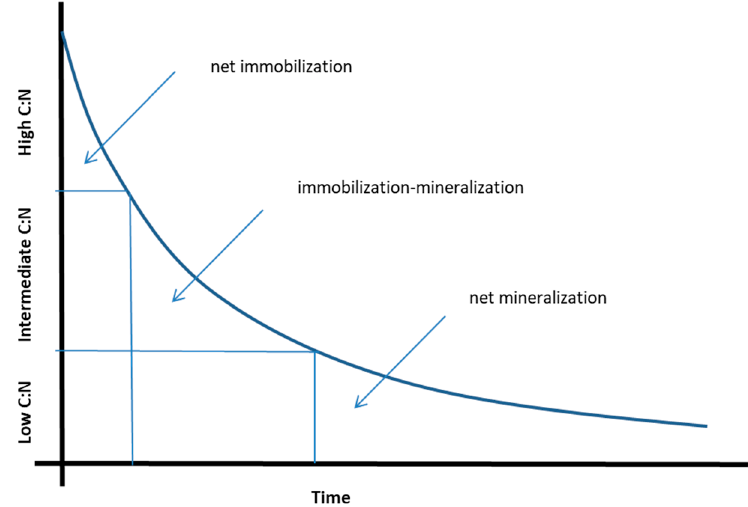
Figure 2. The evolution of C:N ratio of organic inputs during the course of their decomposition in soil.